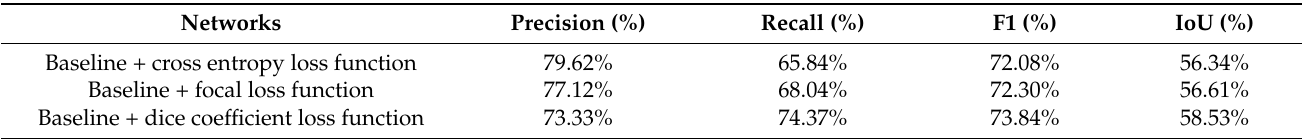
Table 3. Ablation experiments of MSPM and